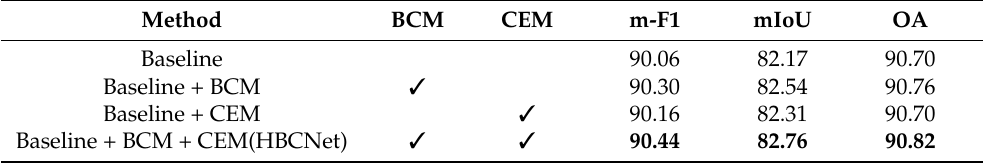
Table 4. Ablation experimental results (%) for the Vahingen dataset. The values in bold are the best.